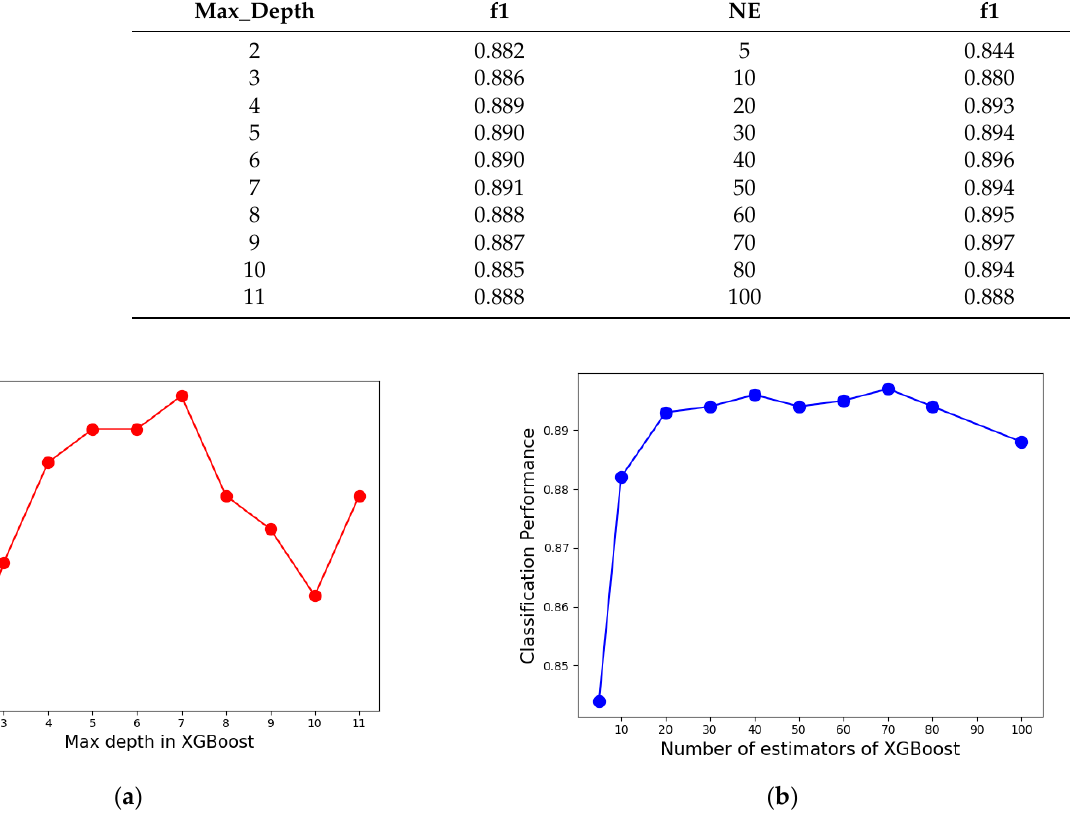
Figure 15. Effect of parameters on XGBoost: ( a ) max depth; ( b ) number of estimators.